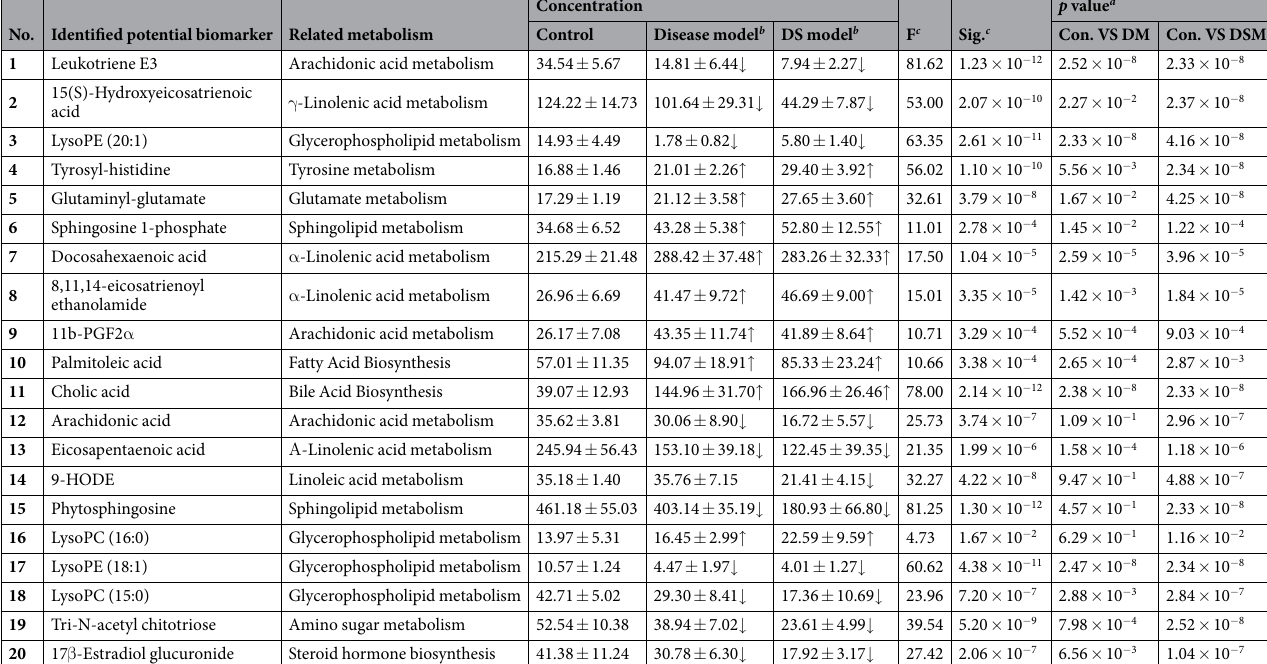
Table 2. Identification of significantly different potential endogenous metabolites in the sera of individuals in the control and model groups a . a Metabolites were confirmed by t R and m / z with authentic chemicals. b Compared with control group. “ ↑ ” indicates a higher level of metabolites, whereas “ ↓ ” represents a lower level of metabolites. All data are represented the intensity values of metabolites. c The value of F and Sig. was obtained from a one-way ANOVA. The F value is the ratio of the variance between the groups and the variance in the group. F value greater than 1 and Sig. less than 0.05 means the differences between groups were statistically significant. d p values were calculated from the Dunnett test in multivariate statistical